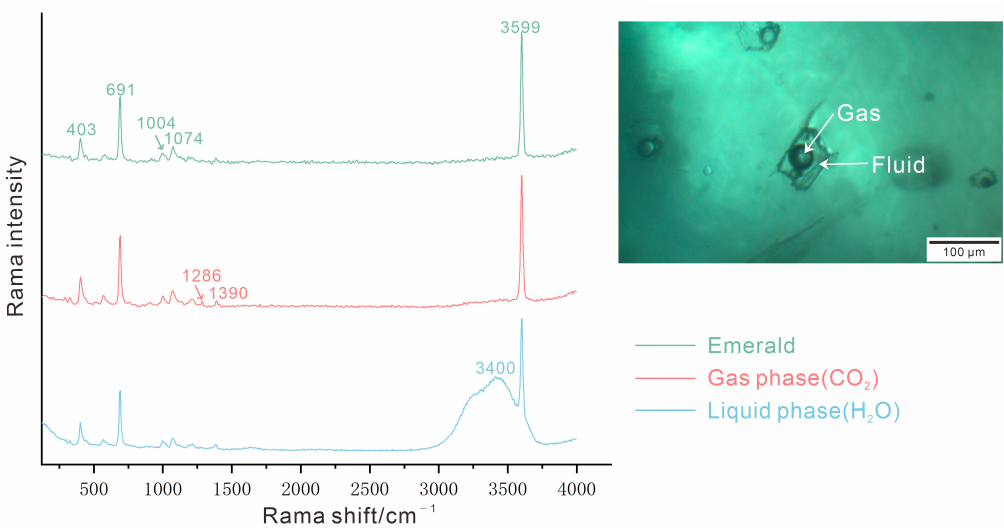
Figure 11. This rectangular three-phase inclusion in a Kamakanga emerald (KAM-44) clearly displays a gas bubble and a colorless crystal. Raman spectroscopy was used to identify the host emerald (green), the CO 2 gas bubble (red), and the liquid phase (blue). The spectra are stacked for clarity. Hexagonal three-phase inclusions were less abundant than rectangular fluid inclusions. The composition of gas bubbles was not detected but was presumed to be CO 2 + CH 4 based on other hexagonal fluid inclusion test results in this paper. Daughter crystals were identified as siderite (peaks at 287, 713, and 1090 cm − 1 ) (Figure 12). The liquid phases were identified as water (a band at 3400 cm − 1